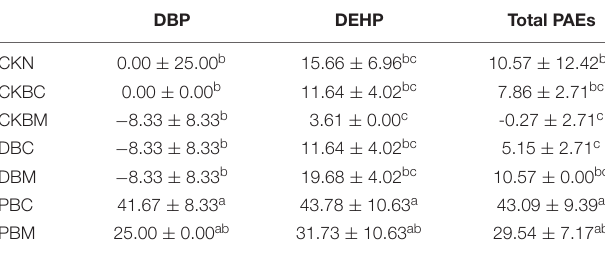
TABLE 4 | The degradation rate of PAEs in soil under the different treatments